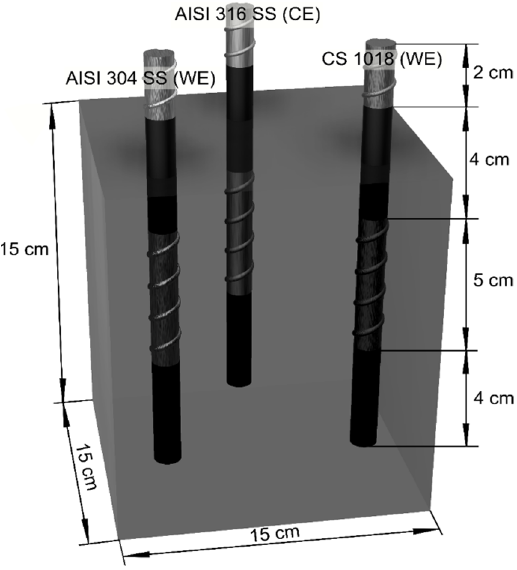
Figure 3. Specifications of specimens for electrochemical tests.